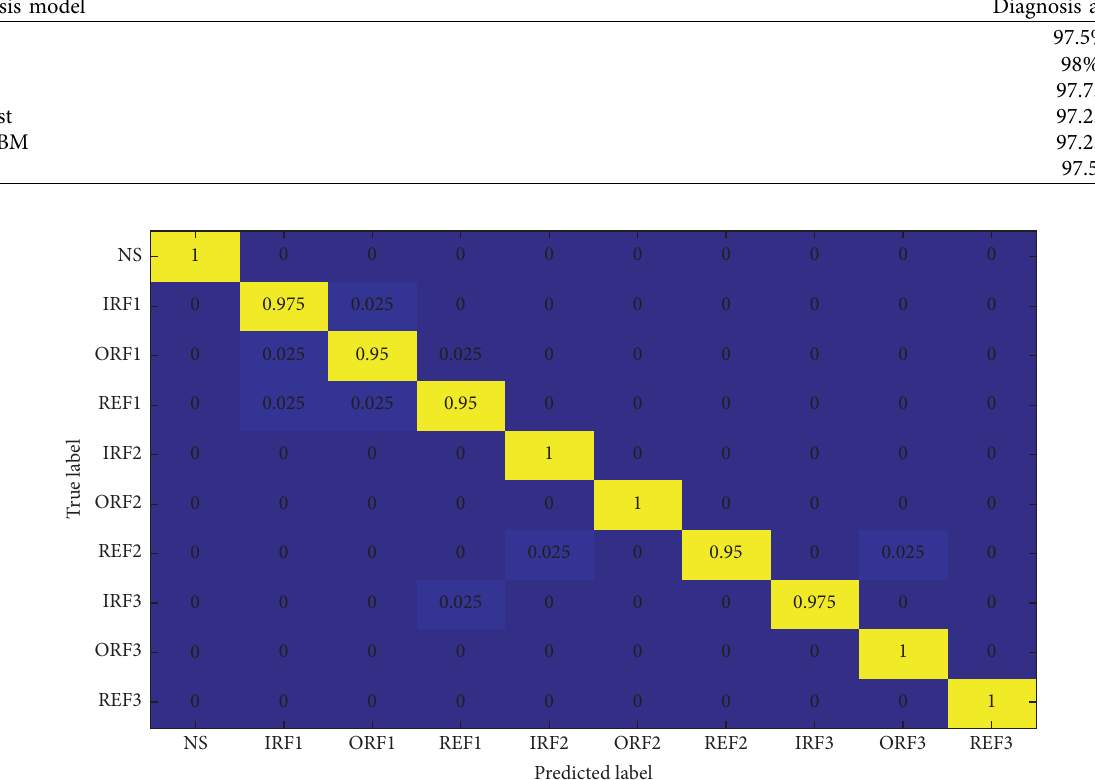
Figure 15: Te confusion matrix of diagnosis result under ten classifcation